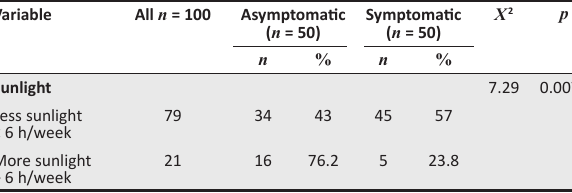
TABLE 4: Sunlight exposure and ethnicity in disease severity. Variable All n = 100 Asymptomatic Symptomatic et al. found decreasing median vitamin D levels in ( n = 50) ( n = patients with increasing severity of pneumonia as described